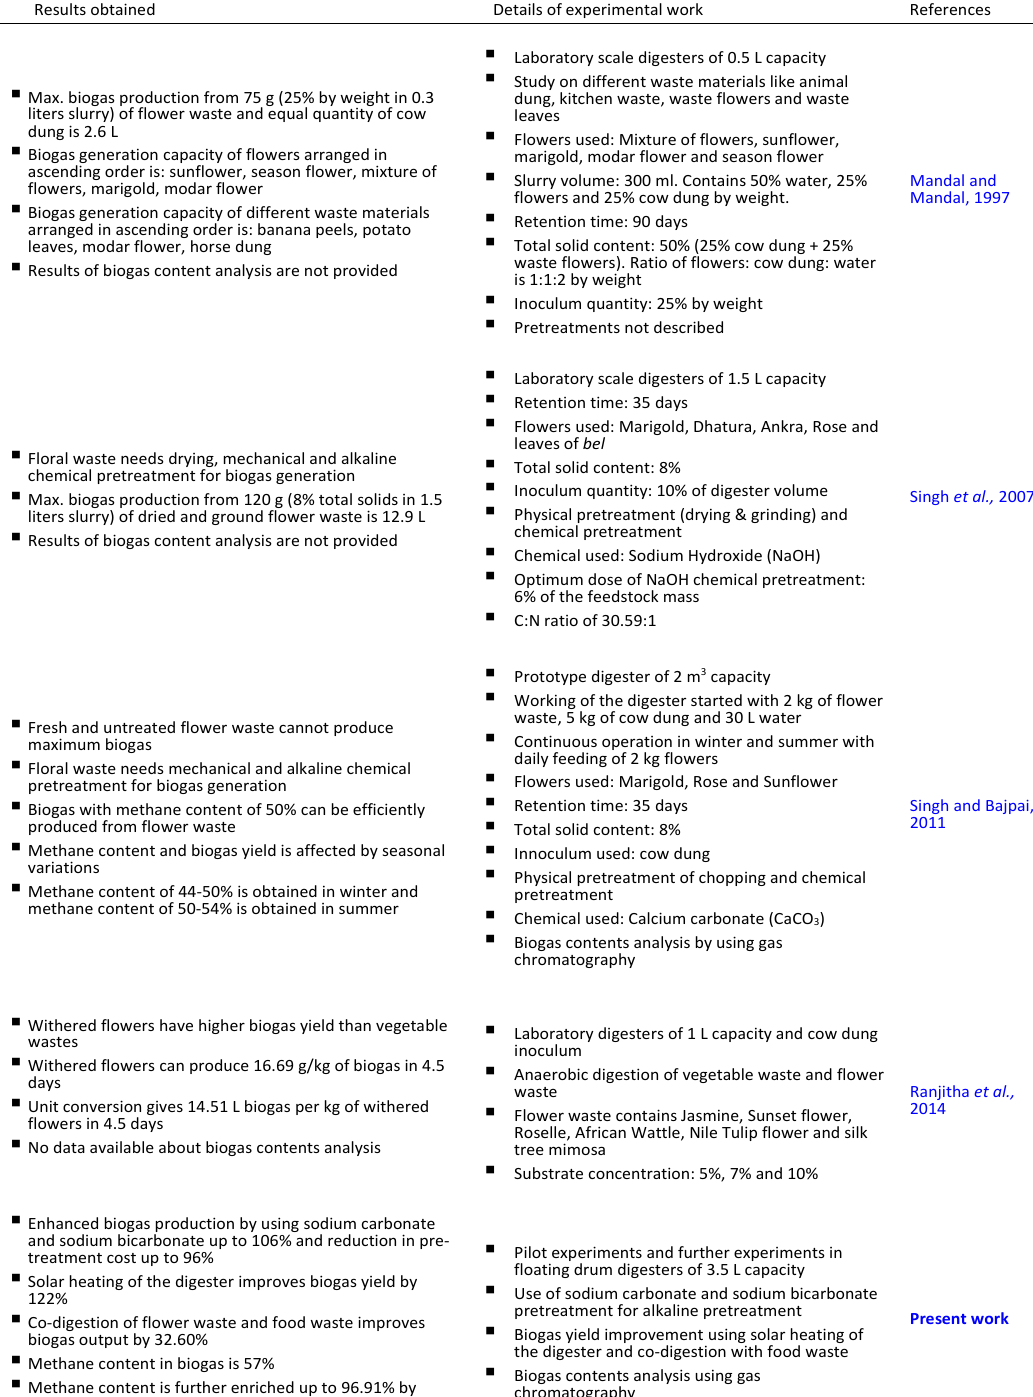
Table 3: Comparison of results and details of experimental work for the present and previous works Results obtained